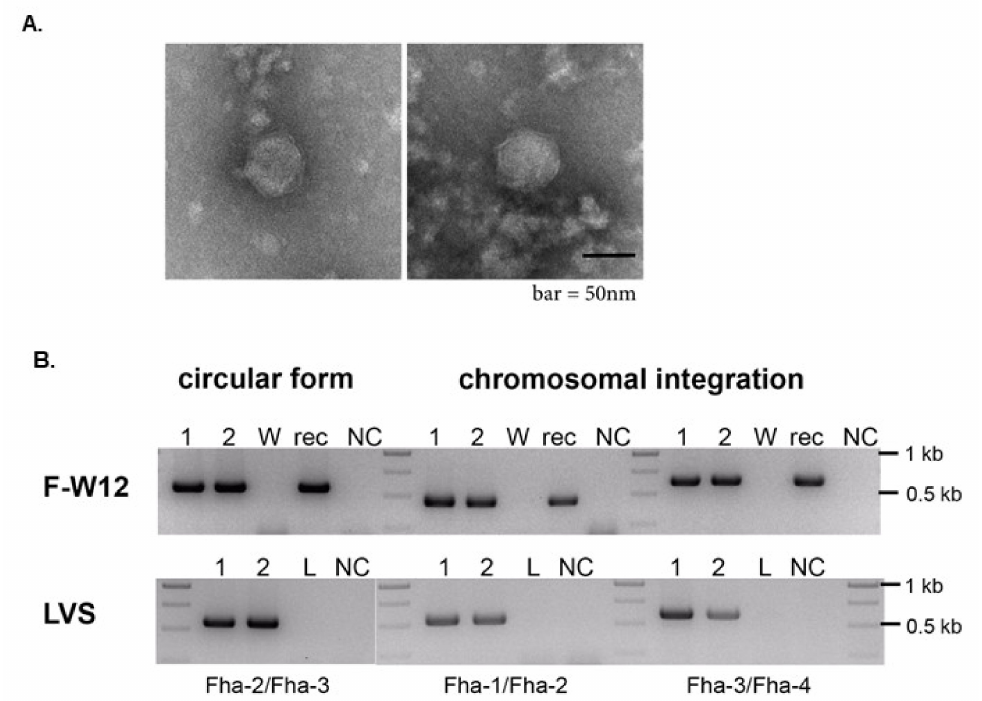
Figure 6. The recombinant bacteriophage KIRK rec . ( A ): Transmission EM of purified KIRK rec stained with uranyl acetate. Phage particles are composed of an icosahedral head ~57 nm. ( B ): Infection of Francisella with KIRK rec . Fth LVS and F- W12 were transformed with the episomal form of KIRK rec by electroporation. Obtained clones were tested regarding the circular form of KIRK rec using primer Fha-2/Fha-3 and the chromosomal integration using Fha-1/Fha-2 and Fha-3/Fha-4, here Fha-1 and Fha-4 are species-specific primers binding in the genome of F -W12 (Fha-1 W12 , Fha-4 W12 ) and Fth LVS (Fha-1, Fha-4*), respectively, see Supplemental Table S1. 1, 2: F -W12 and Fth LVS KIKR rec clones, respectively; W: chromosomal DNA of F -W12, rec: F -W12 KIRK rec clone which was obtained